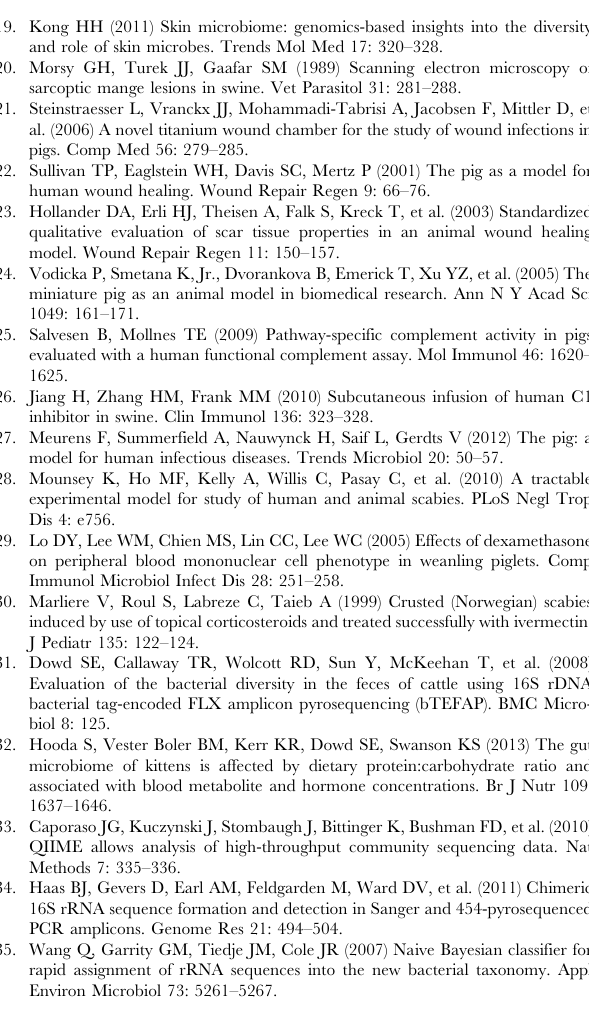
Figure S1 Timeline of experimental trial to monitor the scabies associated microbiota in the porcine model correlating relevant trial time points with the pigs’ ages. Figure S2 Effect of scabies mite infection on the evenness index for all samples from the cohorts C (i, mite free), M (ii, mite infested), MD (iii, mite